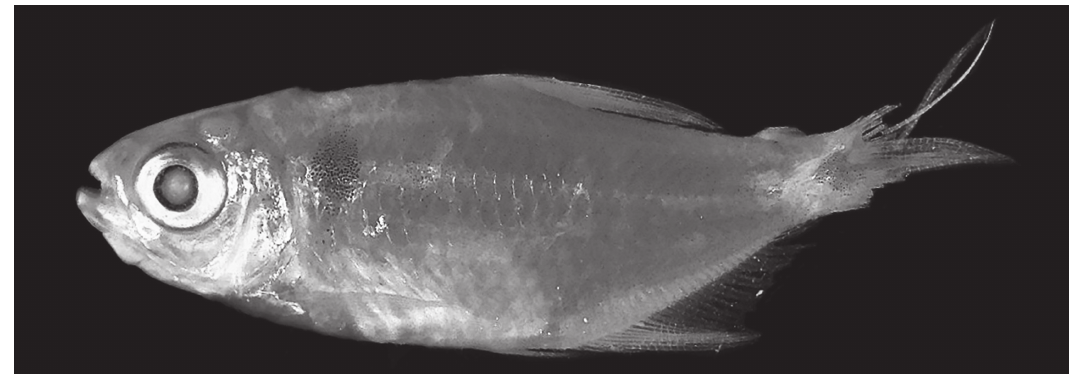
Fig. 4. Specimen of Astyanax hastatus from Santa Cruz, Rio de Janeiro (MCZ 20958, 33.0 mm SL), tentatively identified as Deuterodon pedri by Eigenmann